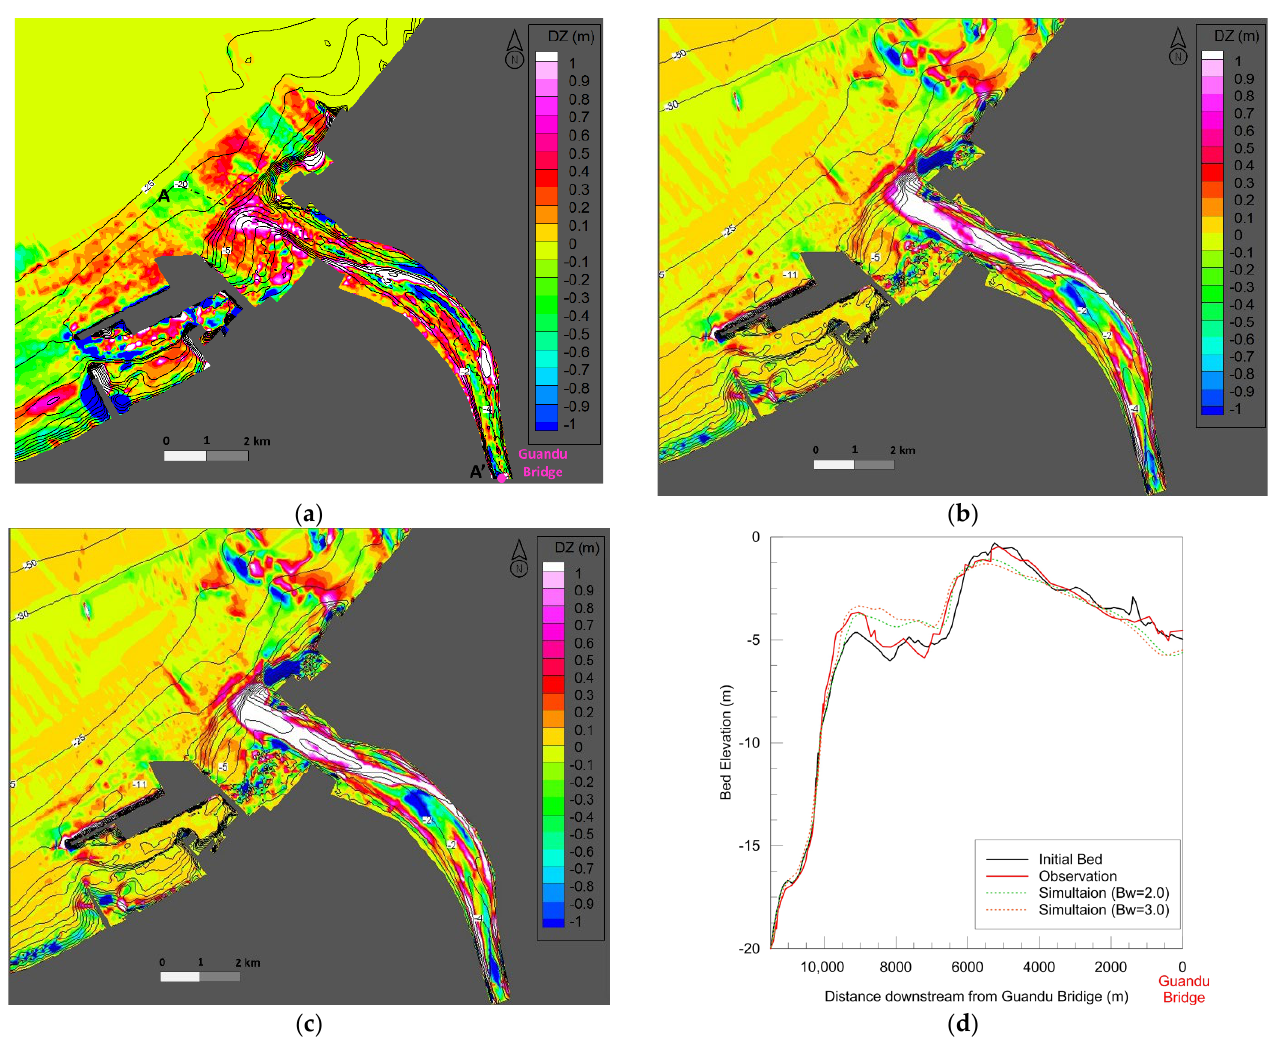
Figure 4. Comparison between measured and simulated bed changes in the Tamsui River estuary. ( a ) Measured bed changes from May to October 2008. ( b ) Simulation results with BW = 2. ( c ) Simulation results with BW = 3. ( d ) Longitudinal profiles of bed elevations along the transect through the middle of the river from the Guandu Bridge to 1500 m of the outer sea of the estuary (dotted line A–A’ in ( a )).